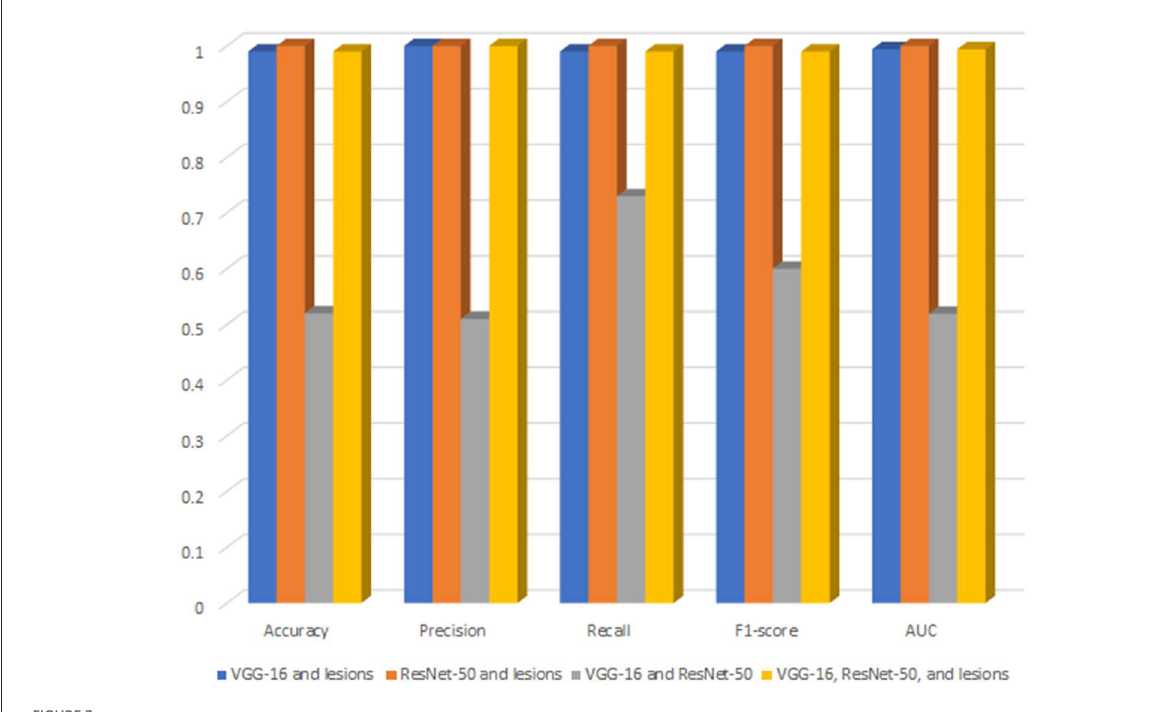
FIGURE3 The performance of XGBoost with all possible combinations of TL and lesion features.